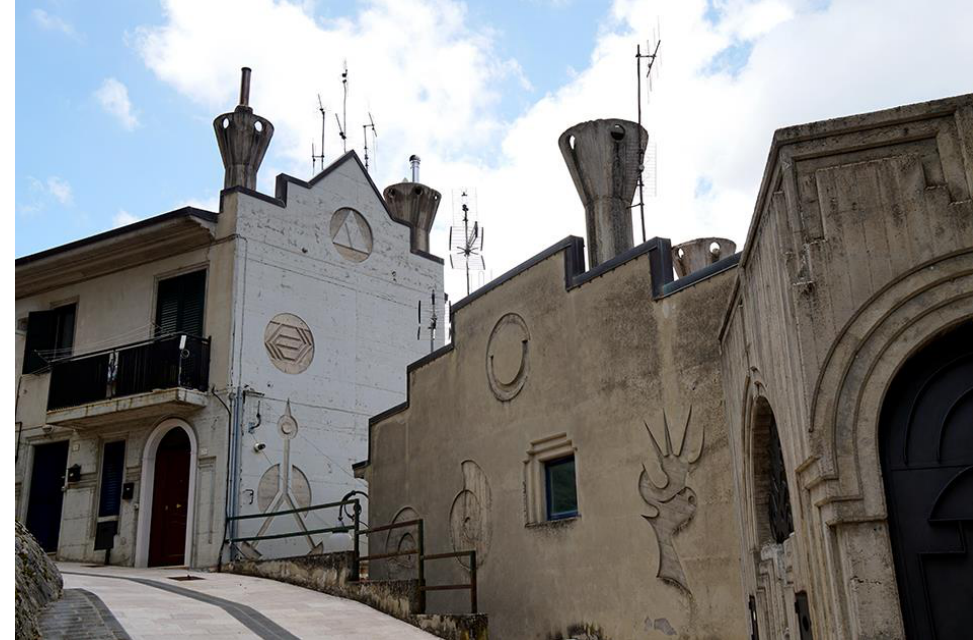
Figure 43. Balvano: the new buildings details of the architecture by R. Boffo and K. Eibl (photos by [35,36]).